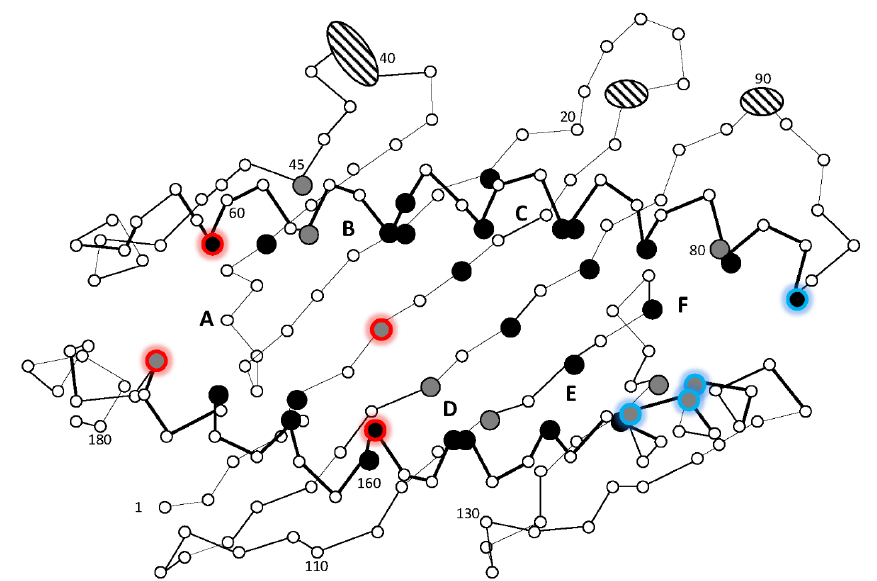
Figure 5. Schematic presentation of the human HLA-A2 peptide binding groove defined by the alpha 1 and alpha 2 domains. The 37 residue positions in HLA-A2 known to contribute to the six A through F pockets [48,49] are enlarged and colored black when completely conserved in the aligned teleost Z1 sub-lineage sequences, while grey represents teleost sequence identity of 90%–99.7%. Residues anchoring peptide N terminal and C terminal ends are shown using red and blue glow respectively.